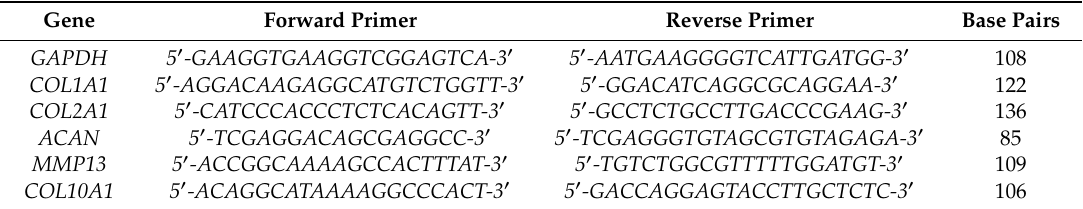
Table 1. Sequences of primers used for real-time